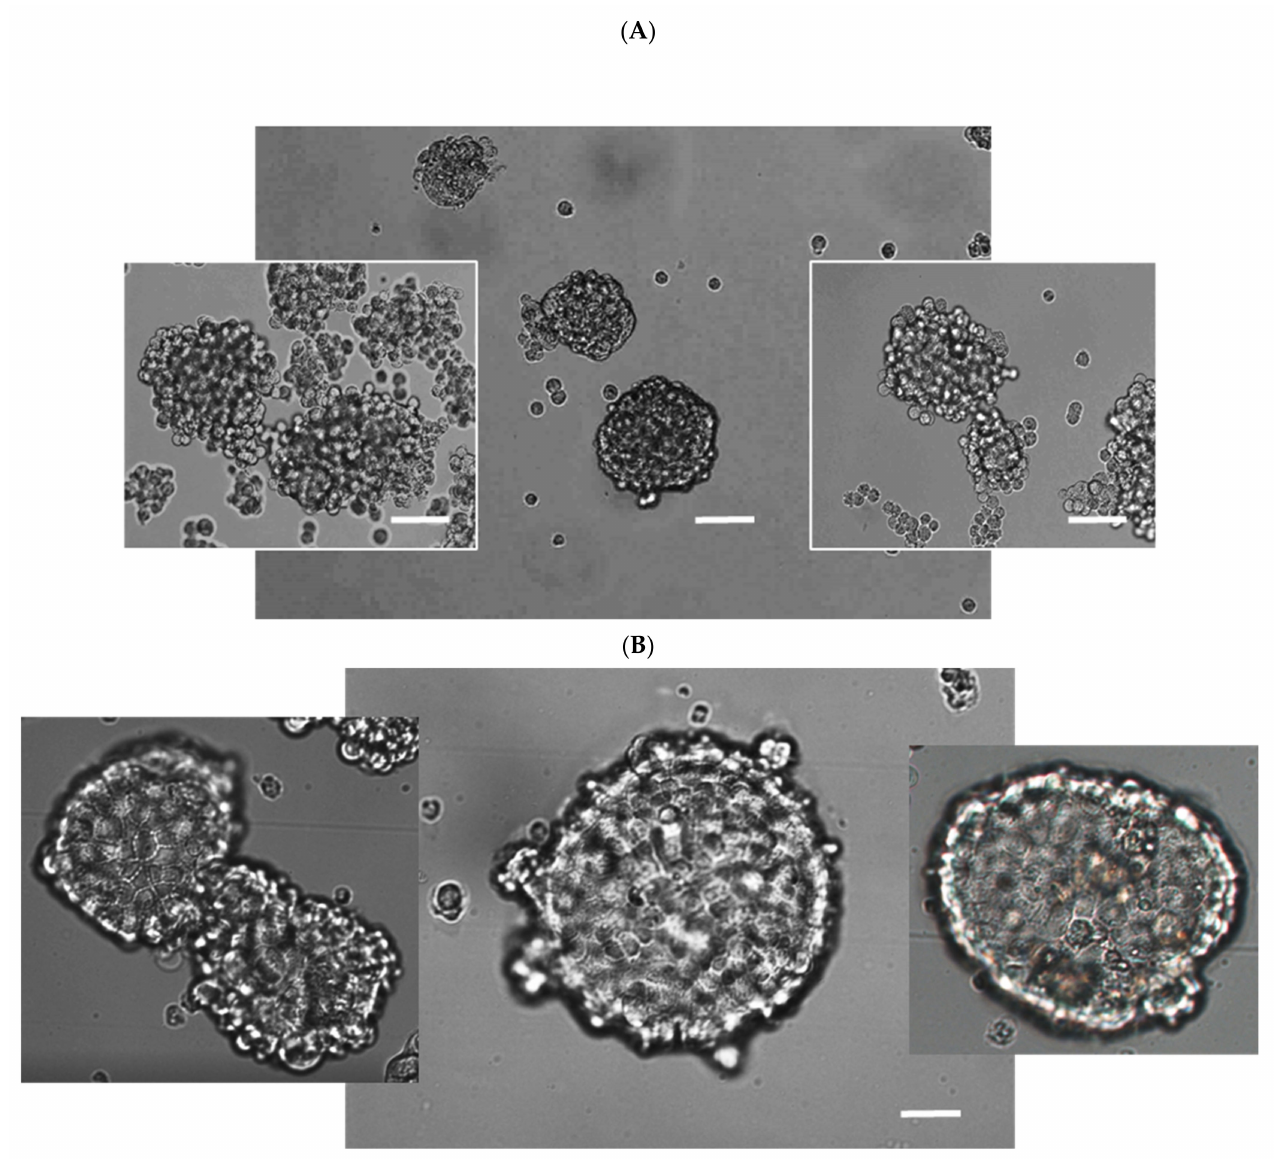
Figure 10. Differential interference contrast (DIC) image of the spheroids formed by A2780 cells ( A ) and OVCAR-3 ( B ) cells. Cells were cultured in ultra-low-attaching dishes as described in the Section 4. Scale bar 50 µ m. Forming spheroids with a fairly loose cell packing (second day of culture) are shown as the side images in Figure (A). Mature A2780 spheroids are presented in the center. In general, the A2780 cells were smaller in size than the OVCAR-3